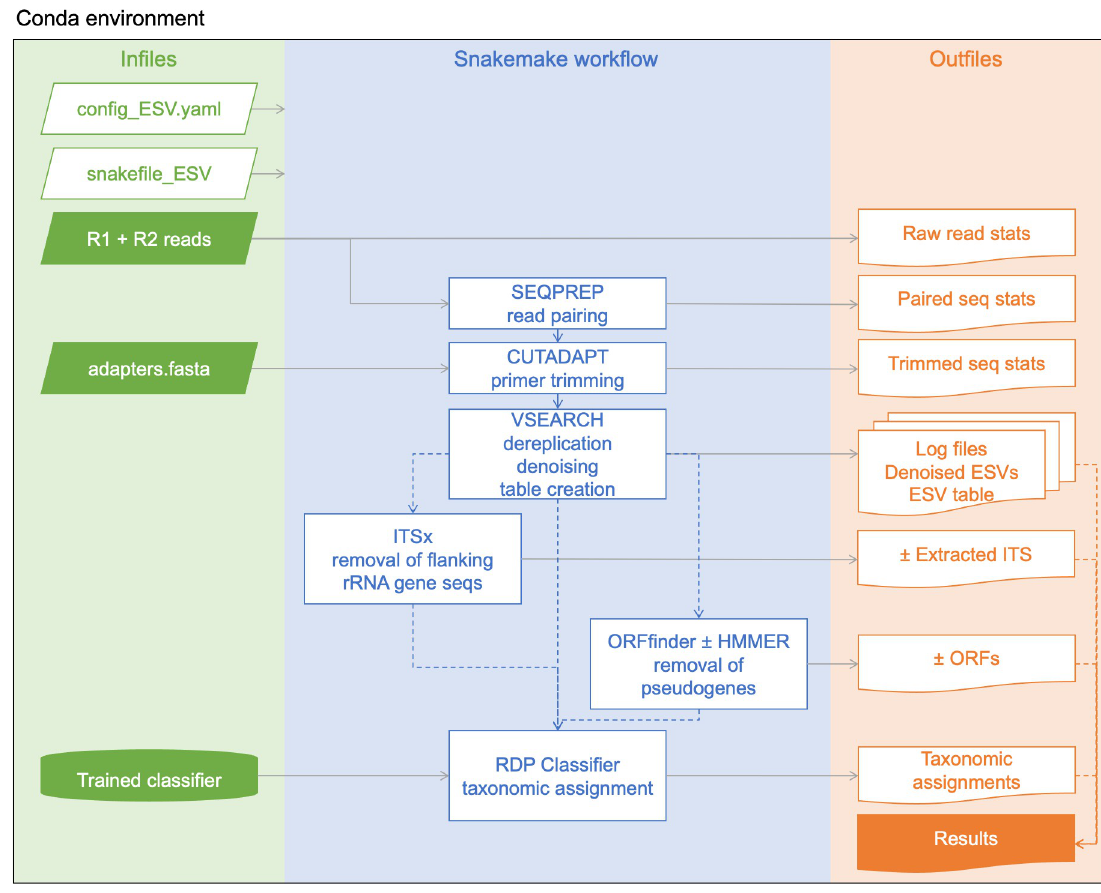
Fig 1. MetaWorks workflow to produce taxonomically assigned exact sequence variants. To aid reproducibility, a Conda environment is provided. Although multiple Snakemake workflows are provided in MetaWorks, here we show the main workflow that generates taxonomically assigned ESVs. Input files are shown in the first panel (green), the ESV workflow is shown in the centre panel (blue), and outfiles are shown in the last panel (orange). The input files in white boxes are required by snakemake to run the appropriate workflow. The input files in green need to be supplied by the user. Note that only custom-trained classifiers such as for COI need to be supplied by the user whereas classifiers built-in to the RDP classifier are used automatically to process prokaryote 16S assignments, for example. The denoising step shown here includes the removal of rare clusters, sequences with putative errors, as well as chimeric sequences. The results are provided in a comma-separated value (CSV) file and shows each ESV per sample with read counts and taxonomic assignments. Abbreviations: Demultiplexed Illumina paired-end reads (R1 + R2), internal transcribed spacer (ITS) region, open reading frame sequences (ORFs).